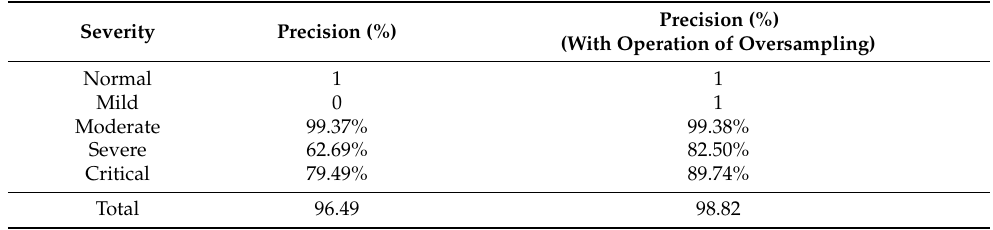
Table 4. Precision of Severity